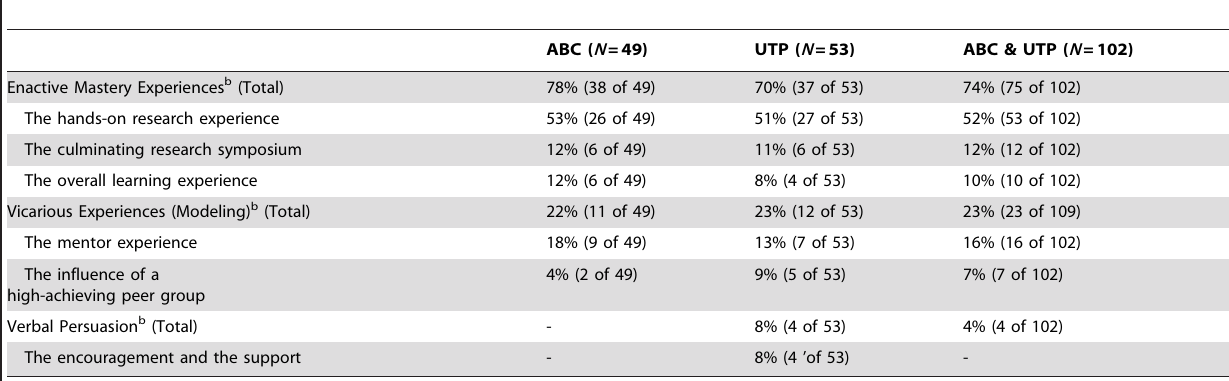
Table 4. Summary List of the Most Valuable Aspects of the Summer Research Experience as Reported by the ABC & UTP Participants a (2008,